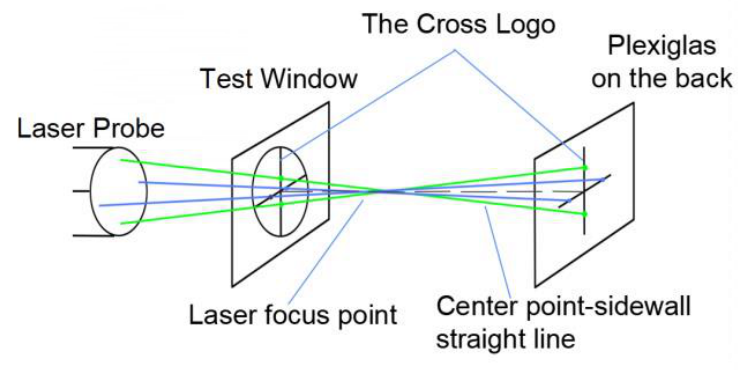
Figure 5. Schematic diagram of laser optical path positioning.